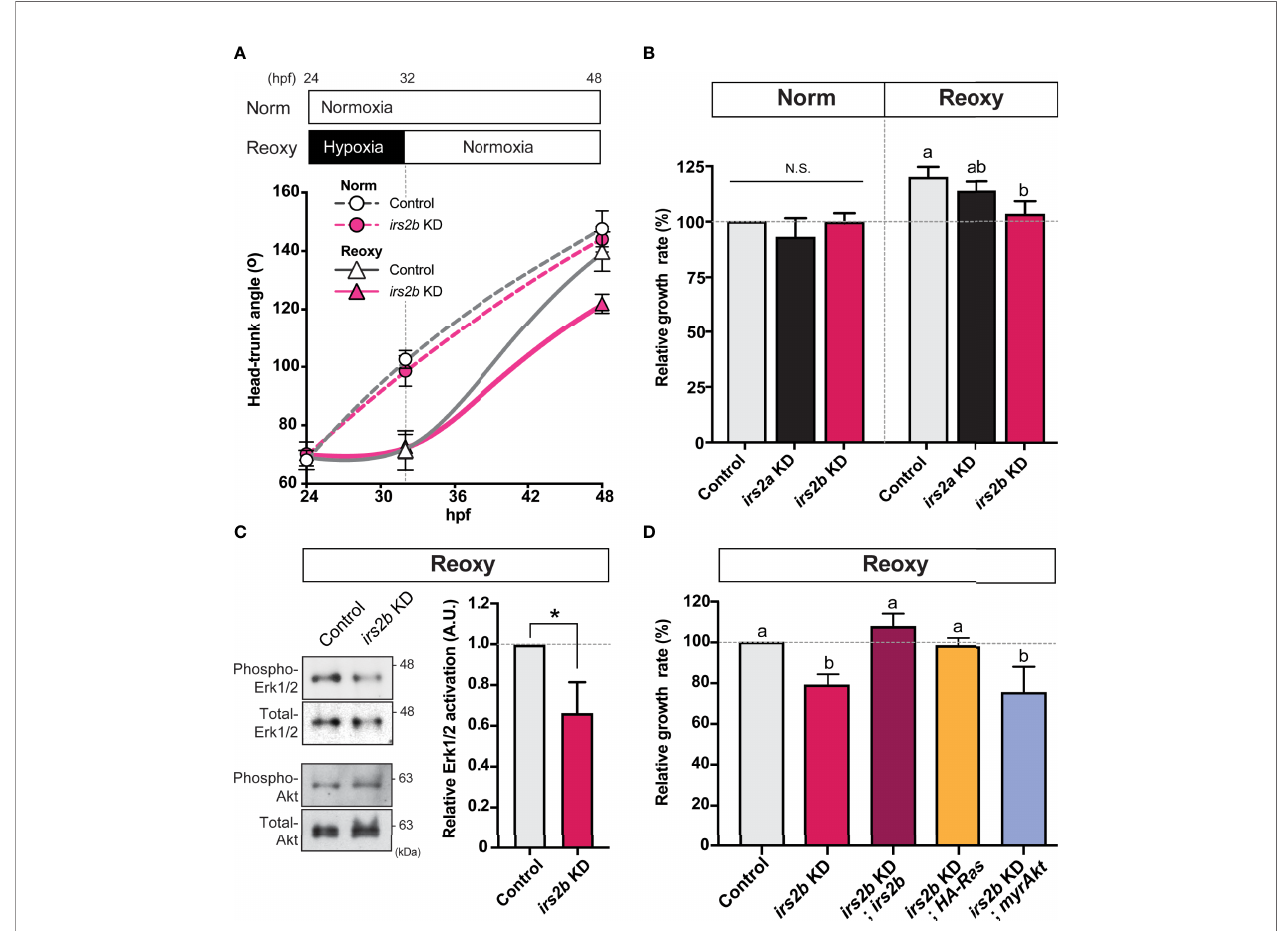
FIGURE 6 | Irs2b, but not Irs2a, is required for Reoxy induced catch-up growth in the zebra fi sh embryo via its Reoxy-speci fi c Erk1/2 activation function. (A) Changes in head-trunk angle. Data are average ± SD, n = 7-12. Embryos lacking the irs2b expression ( irs2b KD) or control MO injected embryos were used for experiments. (B) Relative growth rates in Norm (26-32.5 hpf) and Reoxy (32-48.5 hpf) group. Data are mean ± SE of 3 independent experiments. Values marked with different letters (a, b) are signi fi cantly different from each other ( P<0.05 ), but values marked with common letters (a and ab; ab and b) are not signi fi cantly different from each other ( P>0.05 ). N.S. means not signi fi cantly different (P>0.05). (C) Immunoblot analysis of the phosphorylation levels of Akt and Erk1/2 under Reoxy condition (48 hpf). Data are mean ± SE of three independent experiments. The asterisk (*) denotes statistical difference at P<0.05 . (D) Rescue experiments. Changes in head-trunk angle in the indicated experimental groups. Data are mean ± SE of 2-4 independent experiments. Values marked with different letters (a, b) are signi fi cantly different from each other ( P<0.05